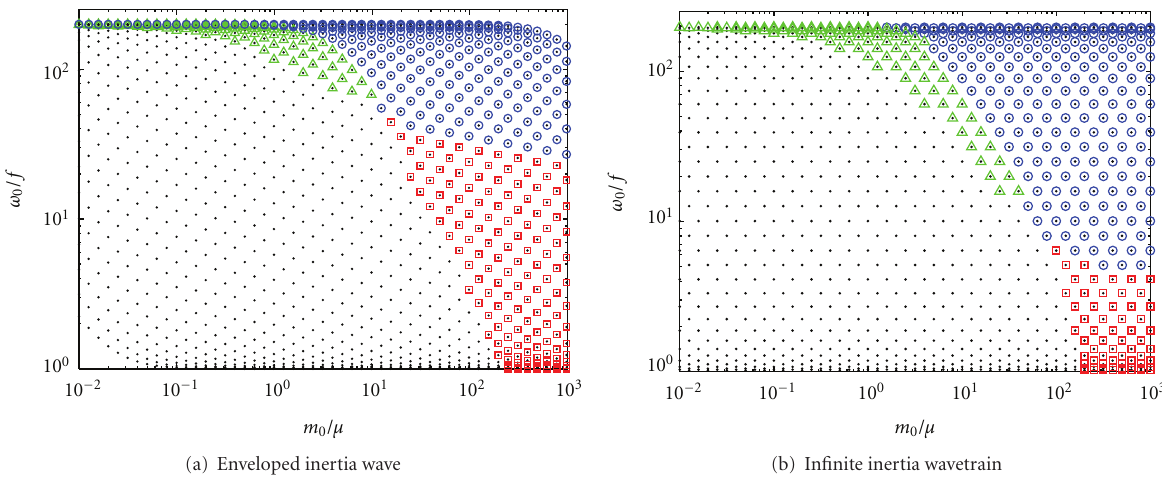
Figure 8: Possibility of turning points (green triangles), critical levels (red squares), or both (blue circles) due to short wave propagation through an enveloped inertia wave (a) and an infinite inertia wavetrain (b) with a maximum horizontal velocity of 5 m/s.